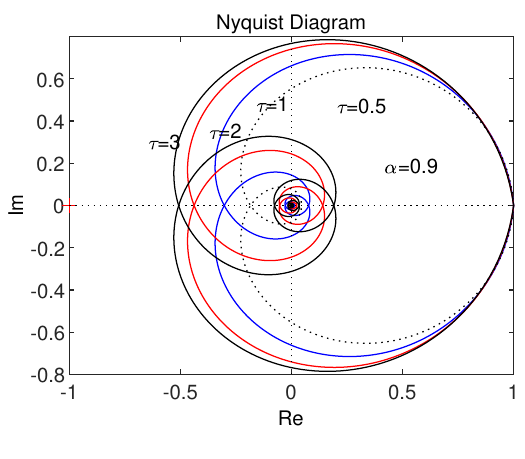
Figure 5. Nyquist diagram of Example 1 for dif- ferent values of α , and fixed τ = 1.